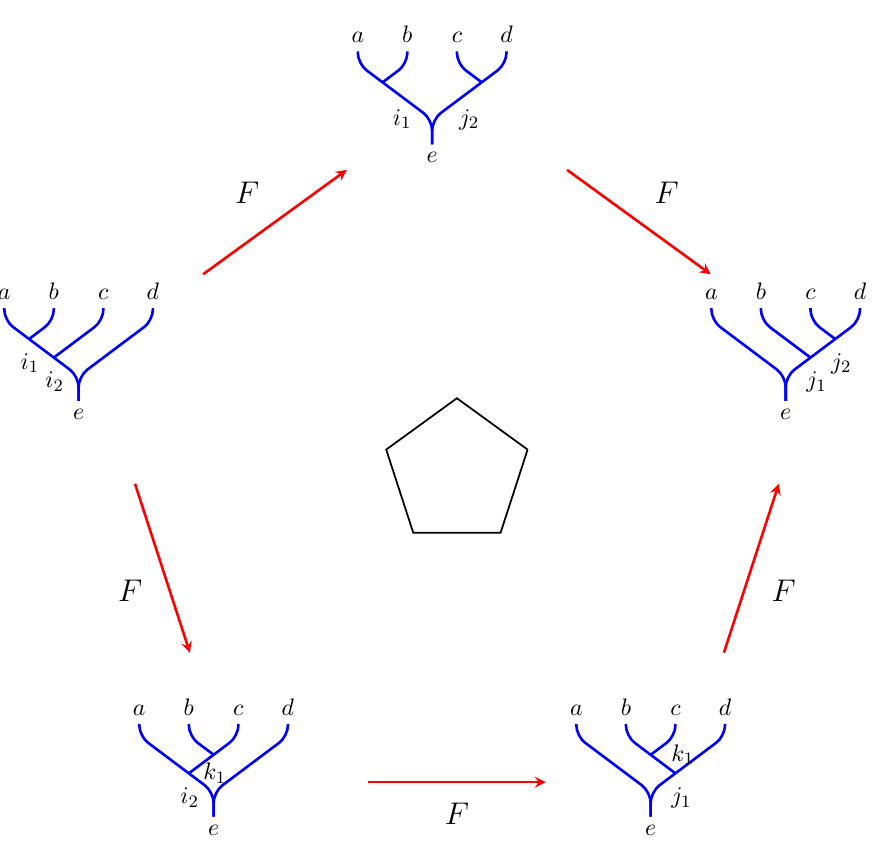
Figure 2 . One can go from left to right either with the two F -moves in the upper part of the diagram or with the three F -moves in the lower part. Equating these two ways to fuse four anyons gives the pentagon identity in (2.6).